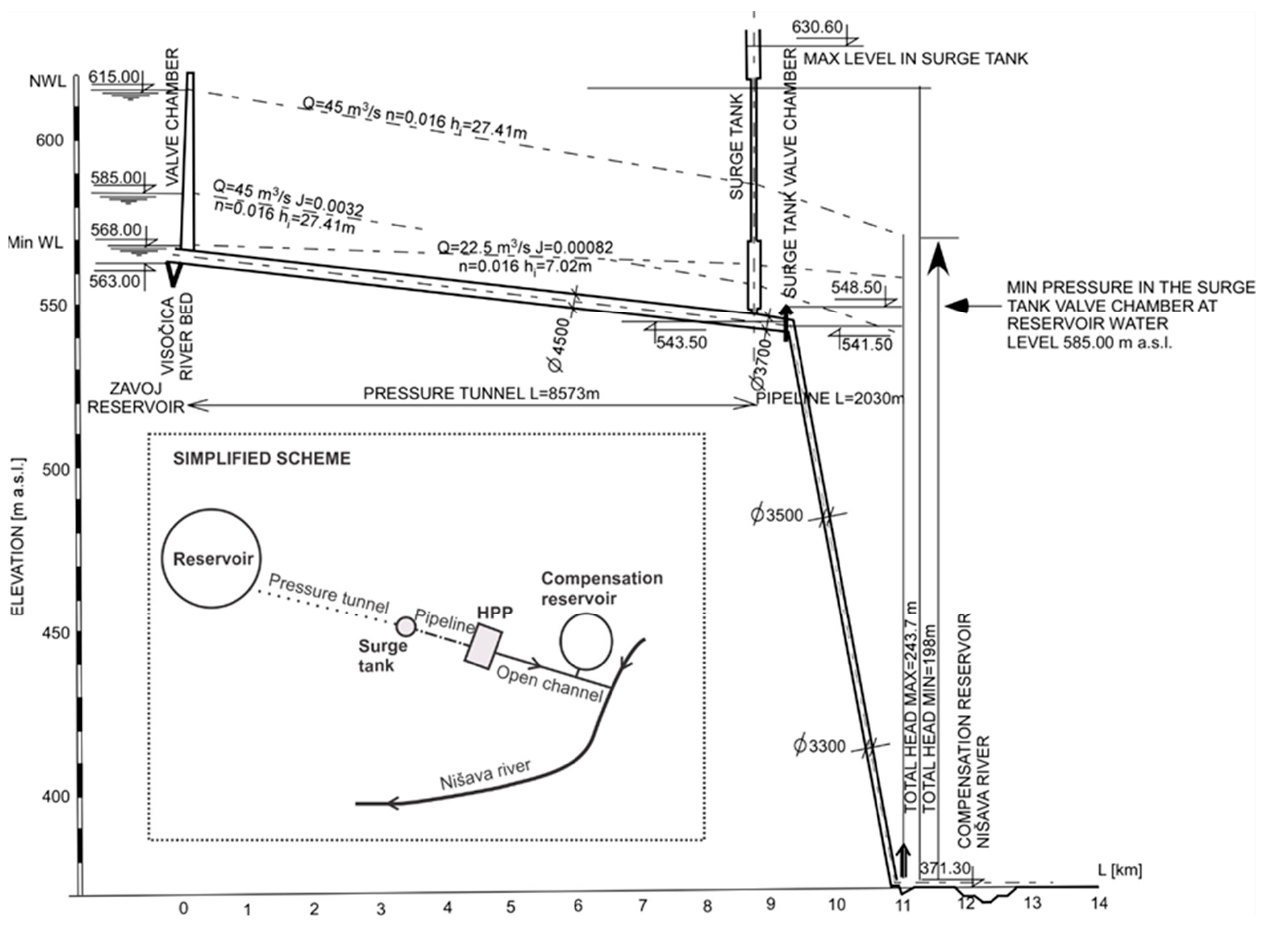
Figure 2. Schematic representation of the Pirot reservoir system [27,28]. The maximum capacity of the bottom outflow is 62.5 m 3 /s. At the gates of the bottom outflow, there is a bypass pipeline used for discharging the environmental flow of 600